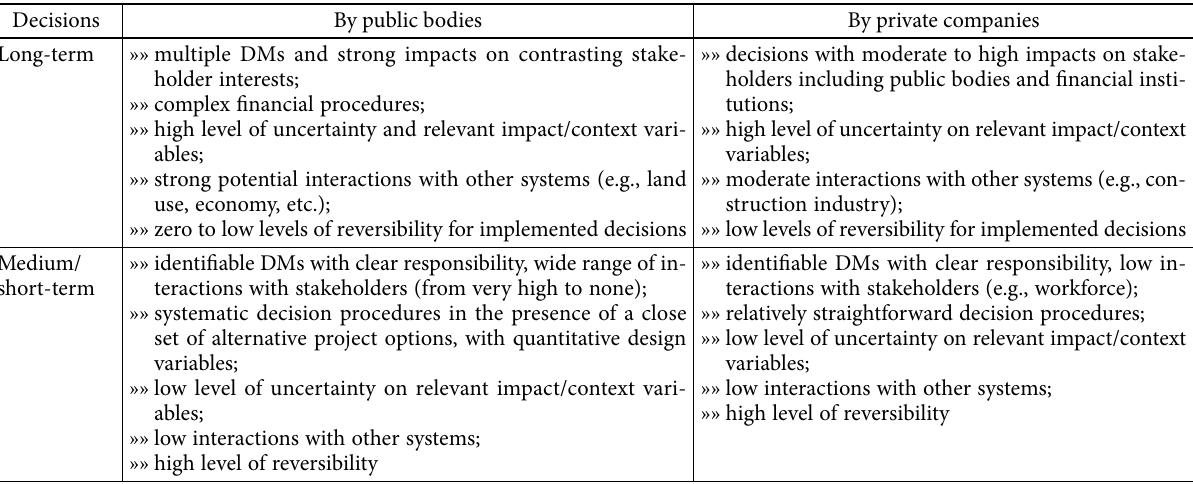
Table 1. The combination of various factors, decisions in transportation decision-making (Cascetta et al. 2015) Decisions By public